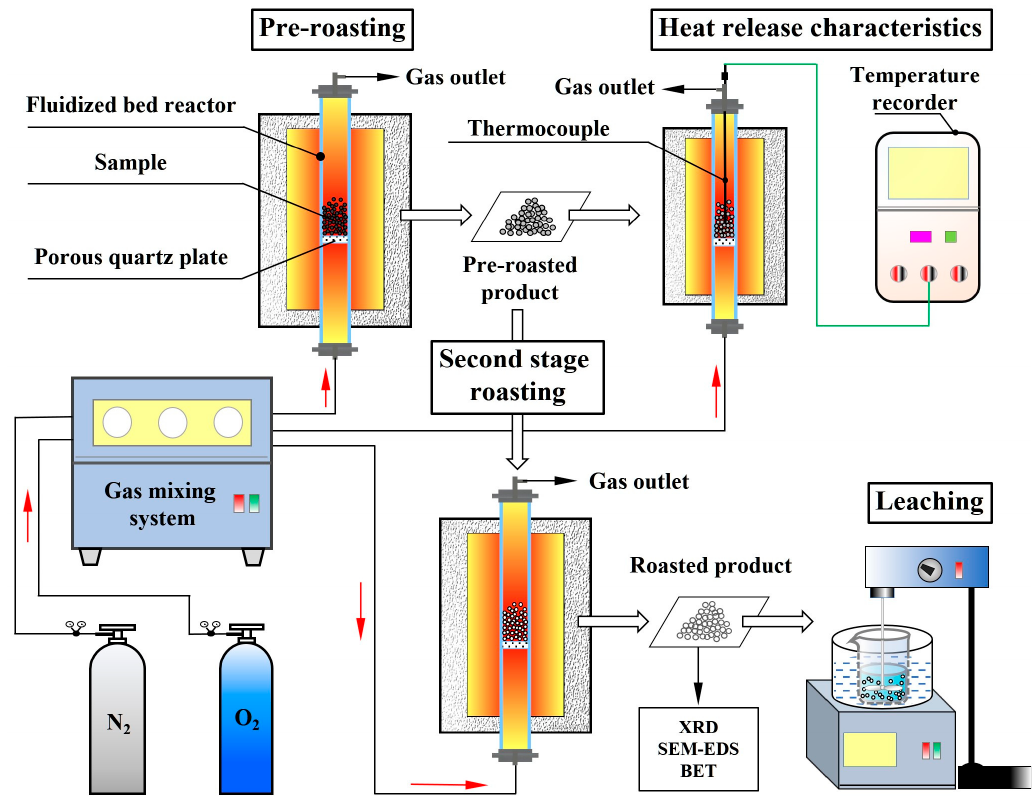
Figure 2. Schematic diagram of the fluidized oxidation roasting followed by leaching experimental system.